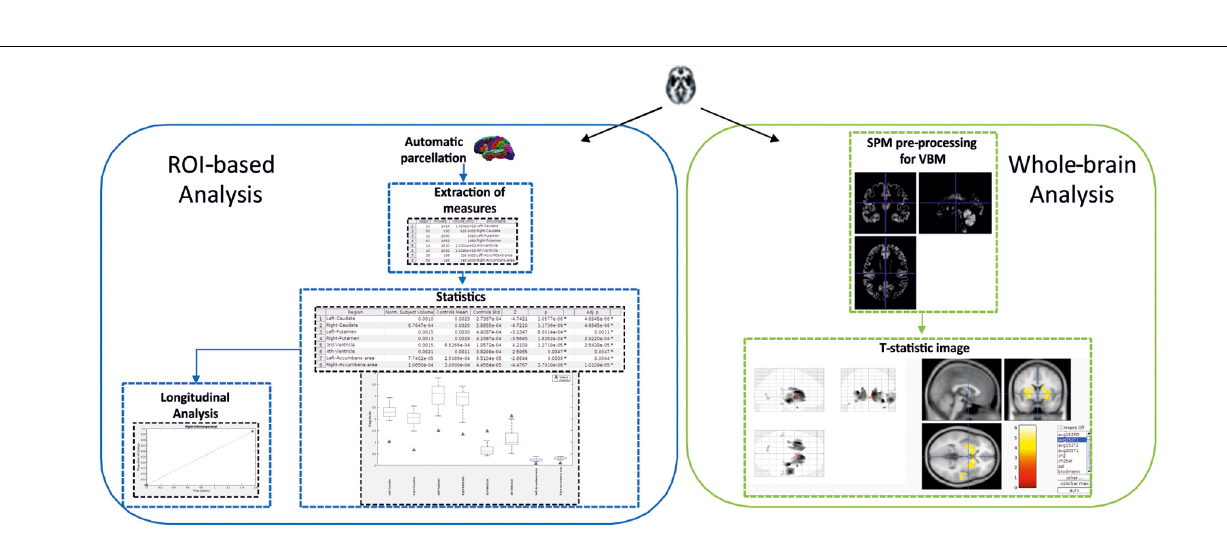
At this point, SeSBAT gives the option to plot the resulting registered images using the testing button. Smoothing can also be applied to the images before statistical comparison by selecting the specific kernel. The resulting T -statistic image derived from the previously used T -test (Crawford and Howell, 1998) can be visualized using the xjView toolbox 4